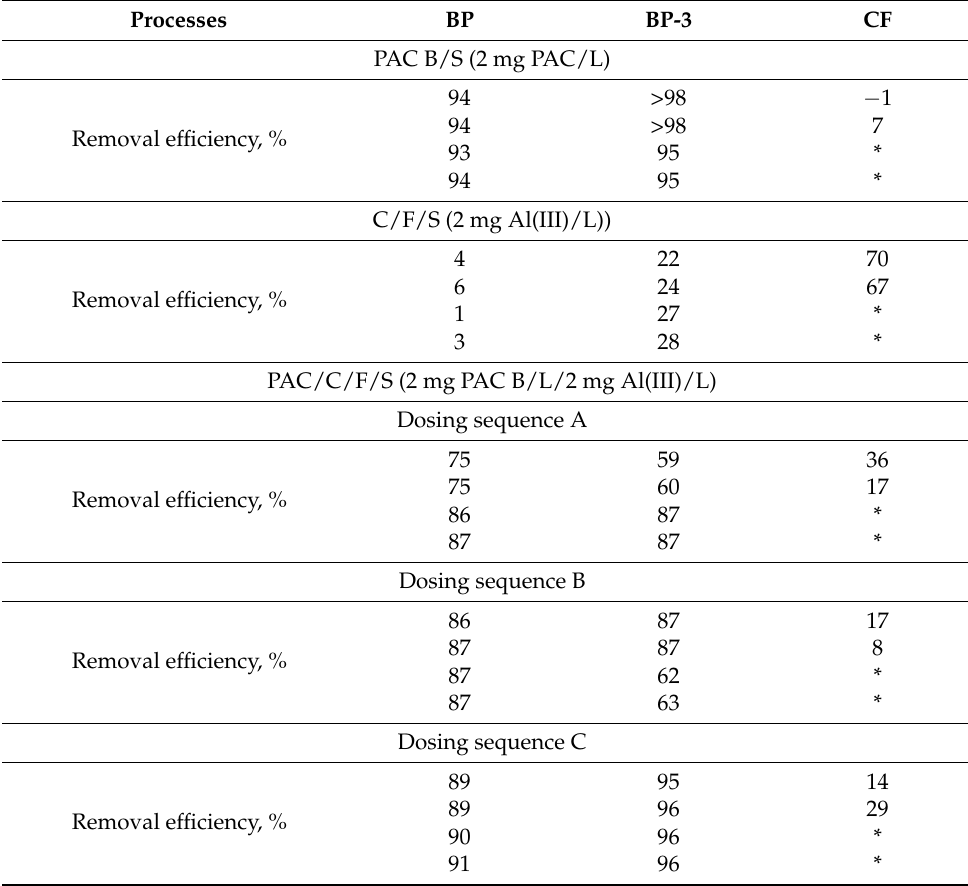
Table 7. Removal efficiency of BP, BP-3 and CF by PAC B/S, C/F/S and hybrid PAC/C/F/S process.